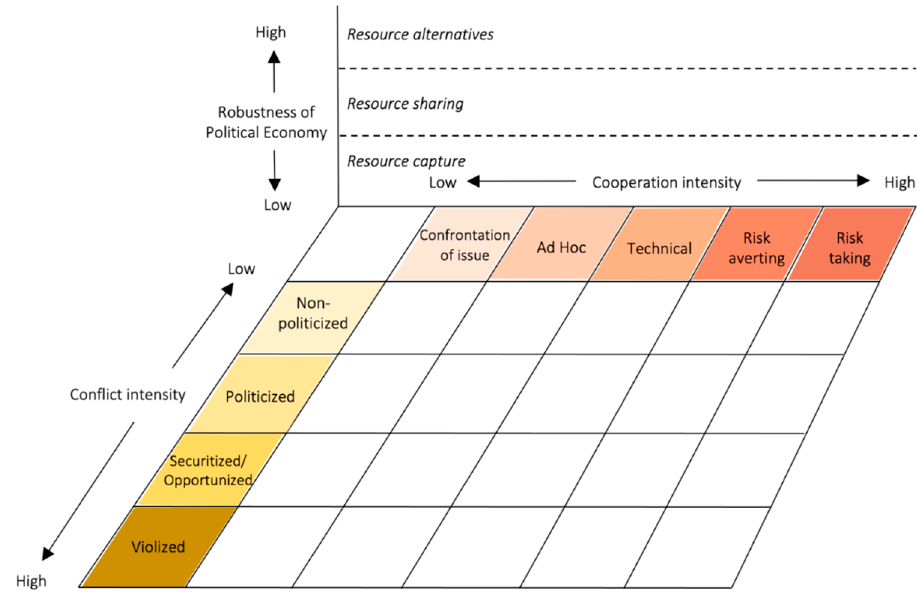
Figure 1. 3D TWINS model (Source: [30]. Adaptation: Karine Legrand).